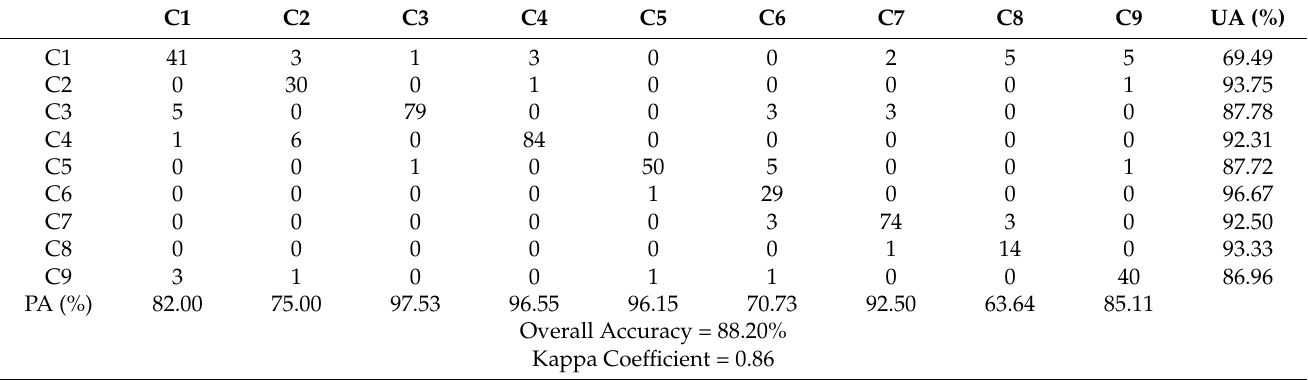
Figure 8. The classification results of the whole study area obtained by the OGCF method. Table 5. The confusion matrix of the OGCF classification results. The matrix shows the number of verification points, producer’s accuracy, user’s accuracy, overall accuracy, and kappa coefficient. C1–C9 are the class codes that represent different land cover classes (see Table